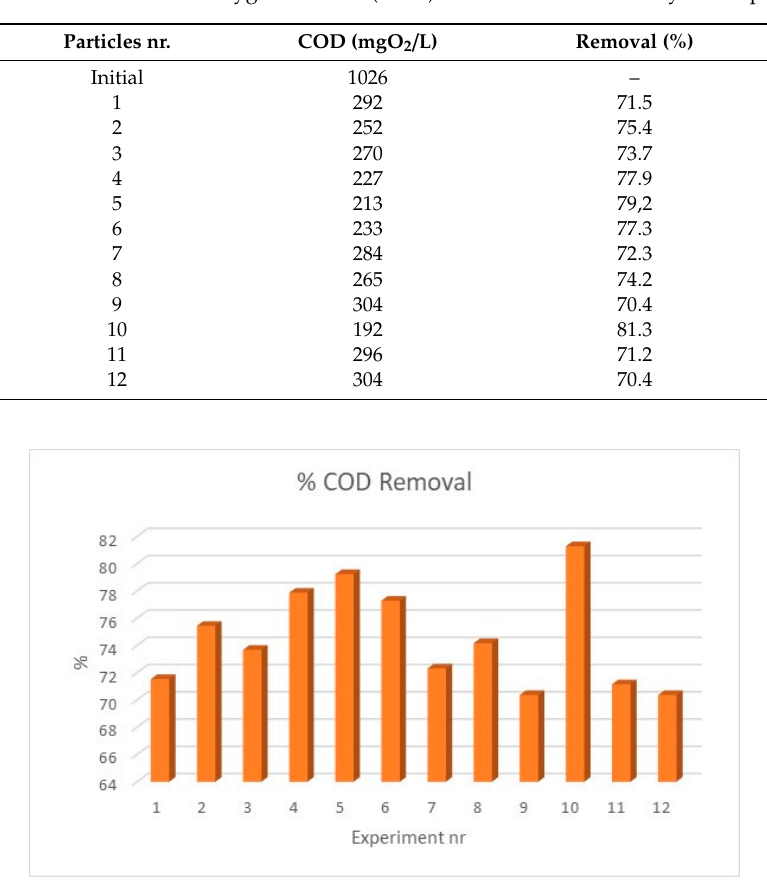
Figure 4. COD removal (%) for the wastewater samples for the particles produced in each experiment.